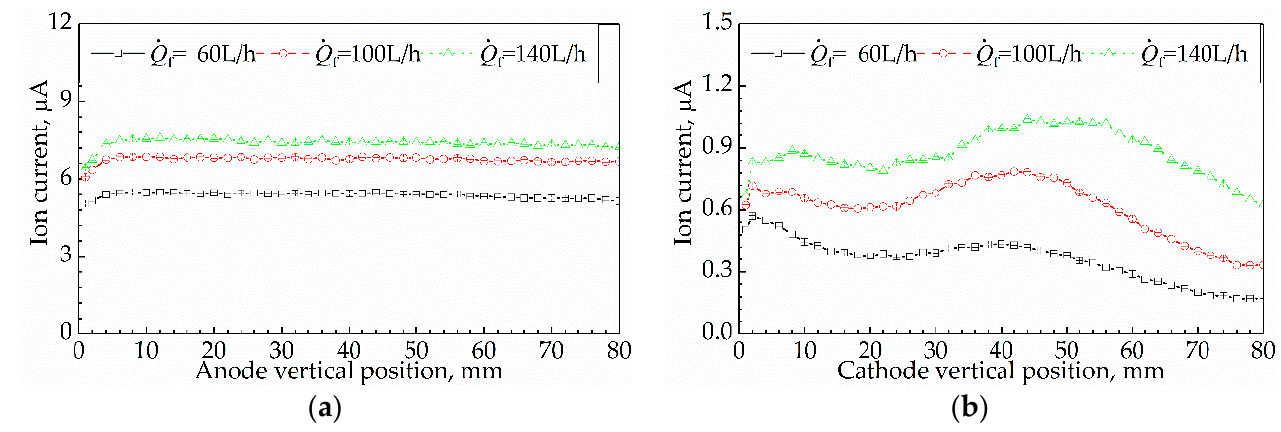
. Q  = 60–140 L/h: ( a ) effect of Q f = 60–140 L/h: ( a ) effect of ∆ 1a on I ; ( b ) effect of ∆ 1c on I f